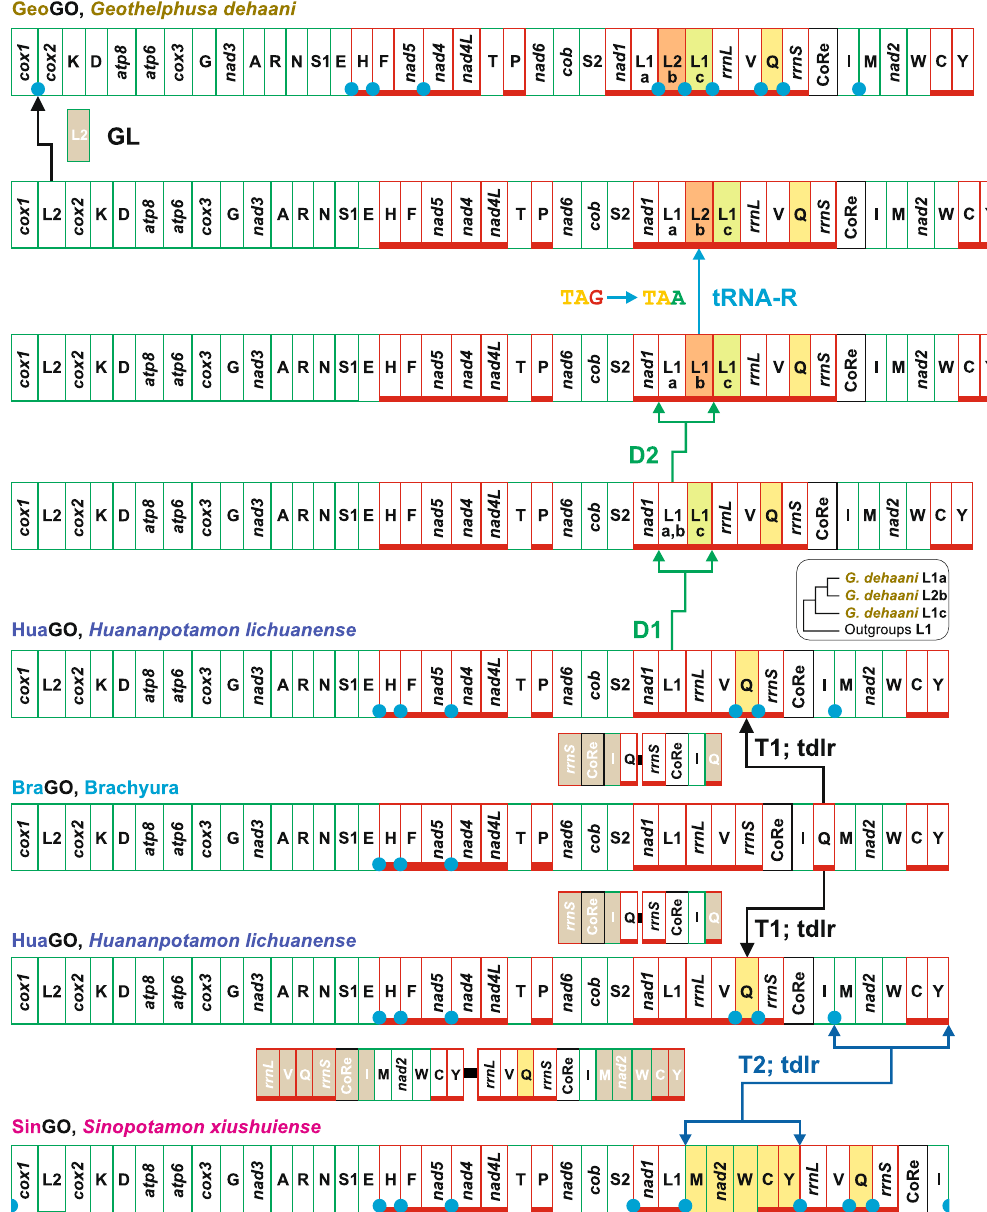
The alternative scenario described above, implies that L1 (a) and L1 (c) are sister sequences (Supplementary Fig. S10). However, the phylogenetic analysis 24 of Brachyuran trnL1s reveals that L1 (a) and L1 (c) are not sister sequences (Fig. 6, Supplementary Fig. S10). Conversely, the pathway presented in Fig. 6 is fully consistent with the available data, and represent in our view the most parsimonious and plausible explanation of the GeoGO evolution. The evolution of GOs in Sesarmidae and Xenograpsus testudinatus. SesGO is the least re-arranged among crab GOs as proved by the highest number of shared common intervals (1,328 on 1,400) with BraGO (Fig. 4). The transposition of trnQ downstream to CoRe is the molecular signature characterizing all the Sesarmid mtDNAs